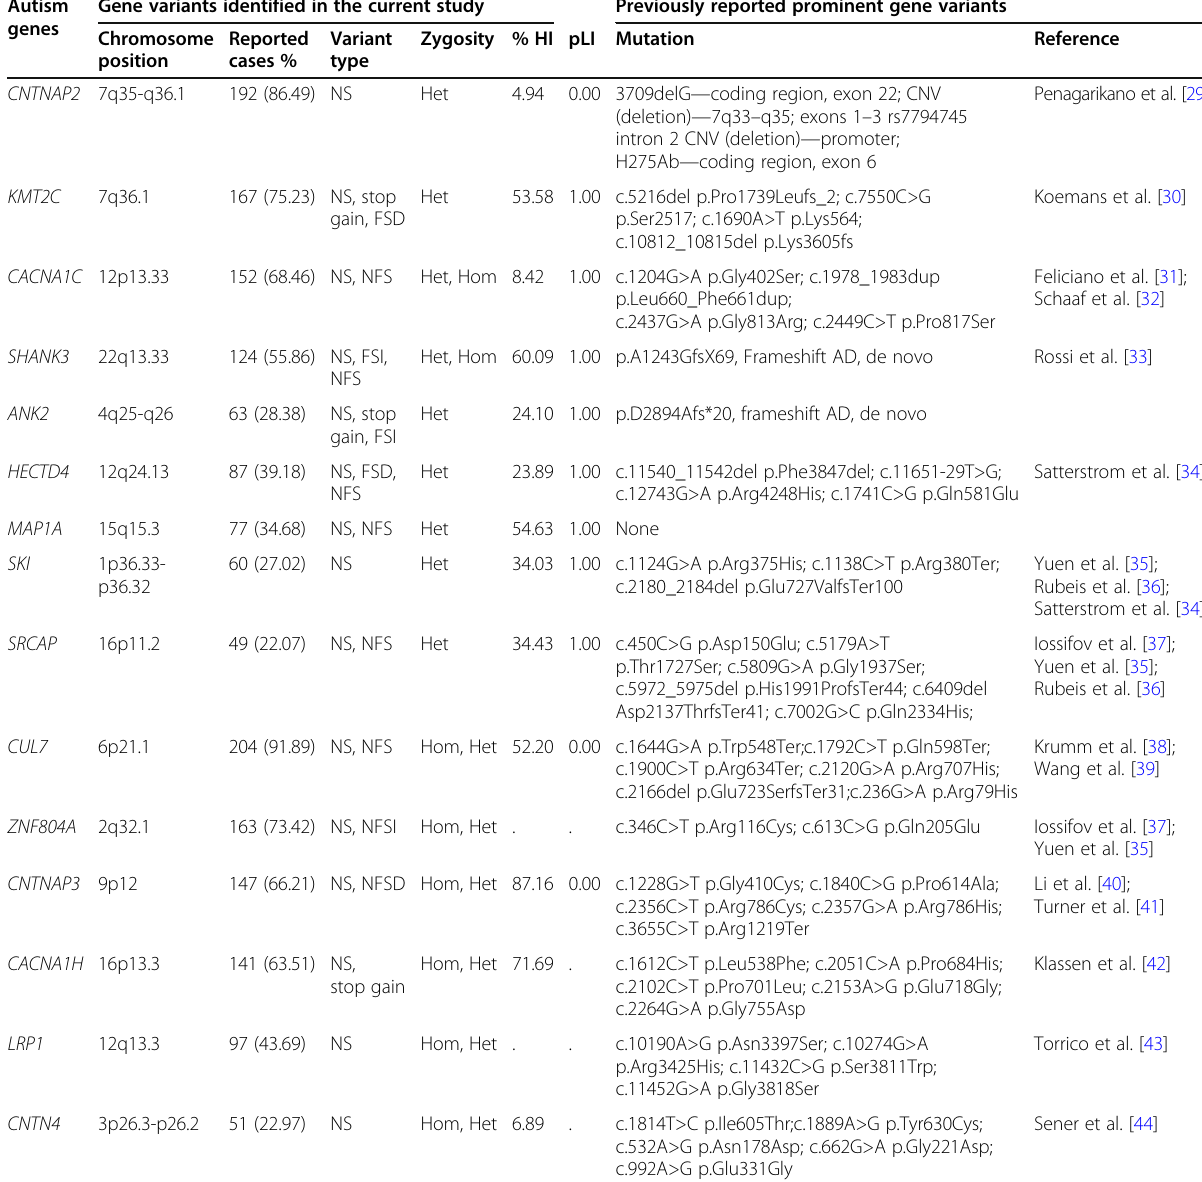
Table 1 Distribution of autism high-risk gene variants in 222 global whole-exome sequences Autism Gene variants identified in the current genes